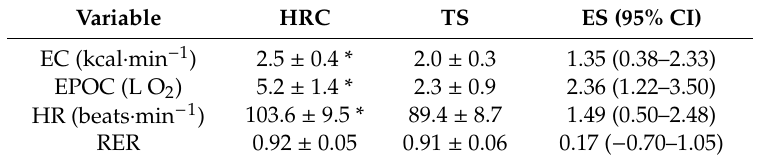
Table 3. Values of cardiorespiratory parameters after each training session (mean ± SD).